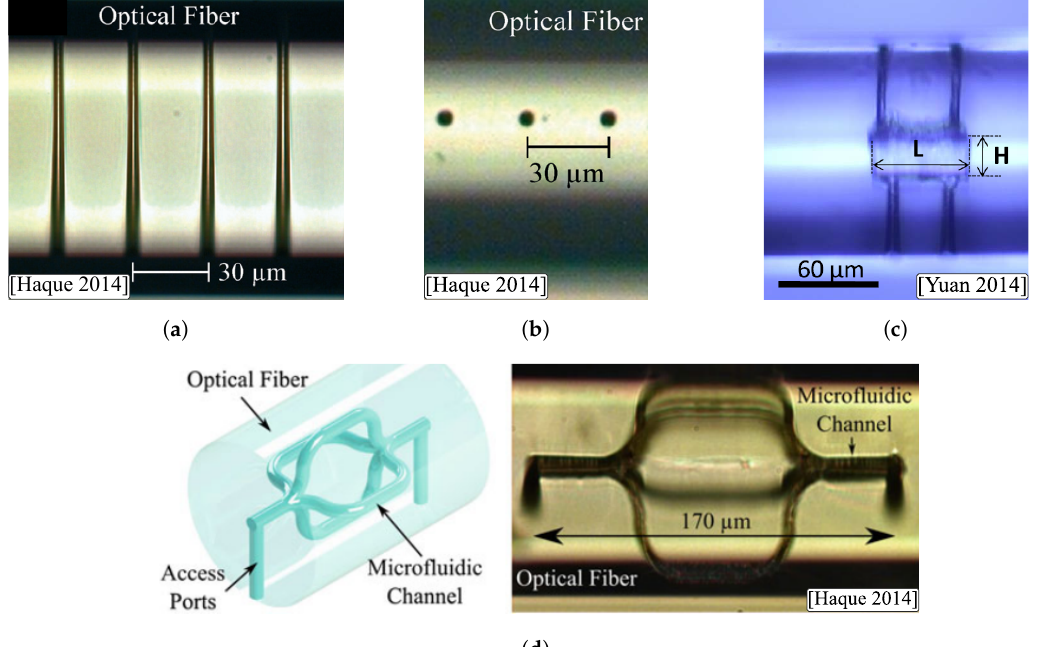
Figure 15. ( a ) Microchannel made in an SMF (lateral view) [8]. ( b ) Top view of the microchannel access ports manufactured in SMF [8]. ( c ) Fabry–Perot cavity manufactured by chemical etching through different access microchannels (adapted with permission from [128], ©The Optical Society). ( d ) Schematic and image of a 3D microfluidic network manufactured within a coreless optical